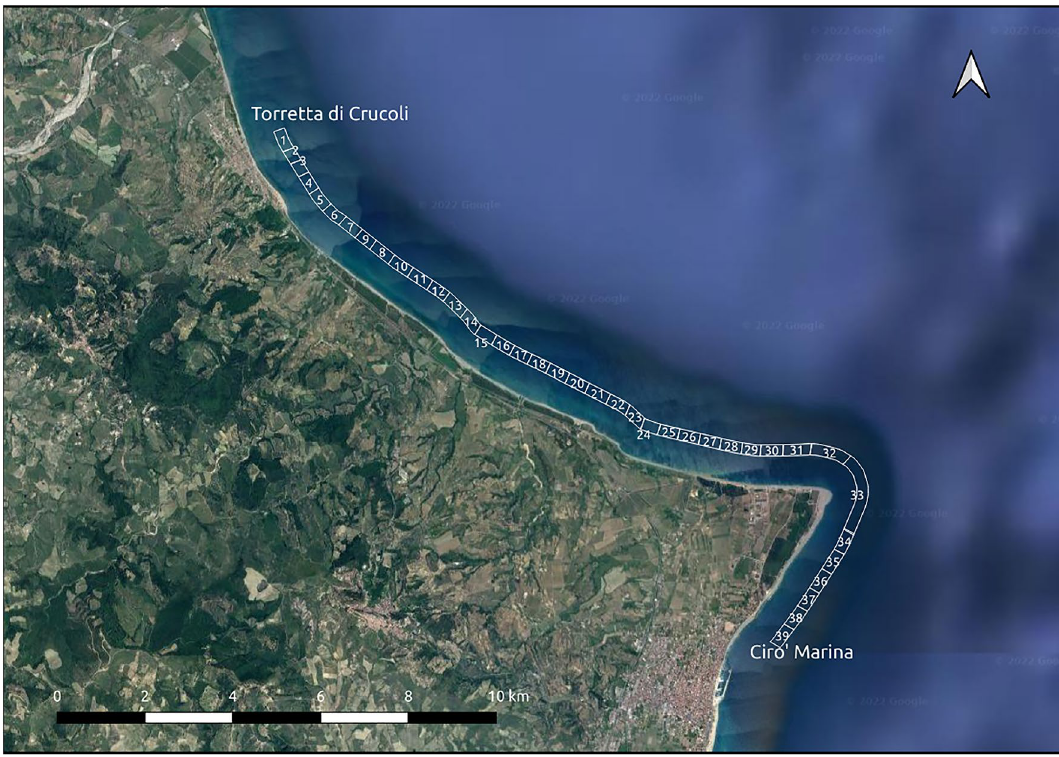
Figure 2. Case study area and related transects. The map was created using QGIS 3.29 software (https:// qgis. org).